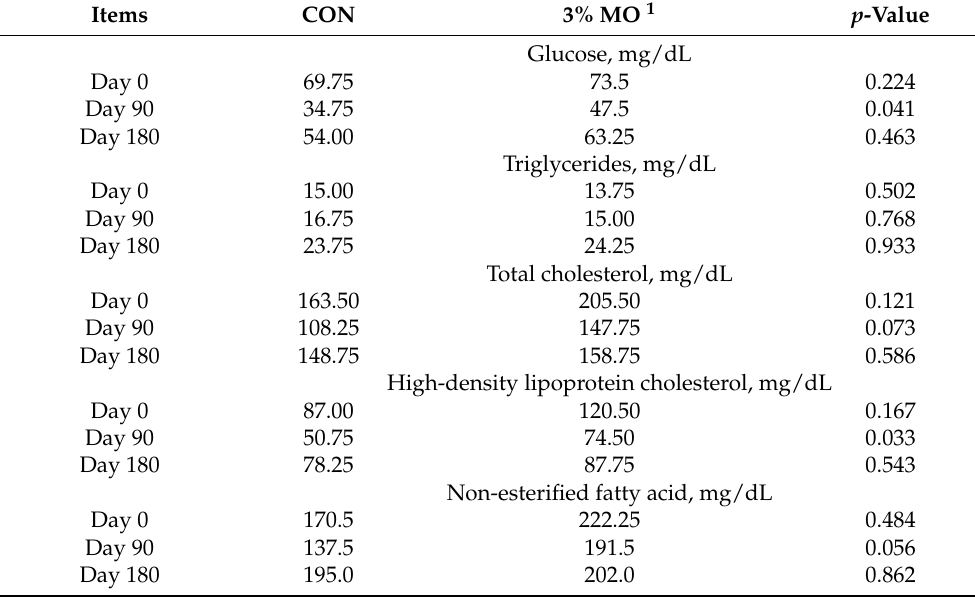
Table 5. Biochemical analyses of blood in steers supplemented with concentrate containing 3% rumen-protected microencapsulated supplement (MO).